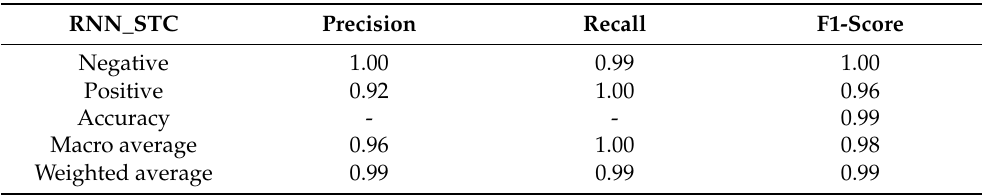
Table 6. Confusion matrix obtained by RNN on the STC dataset.